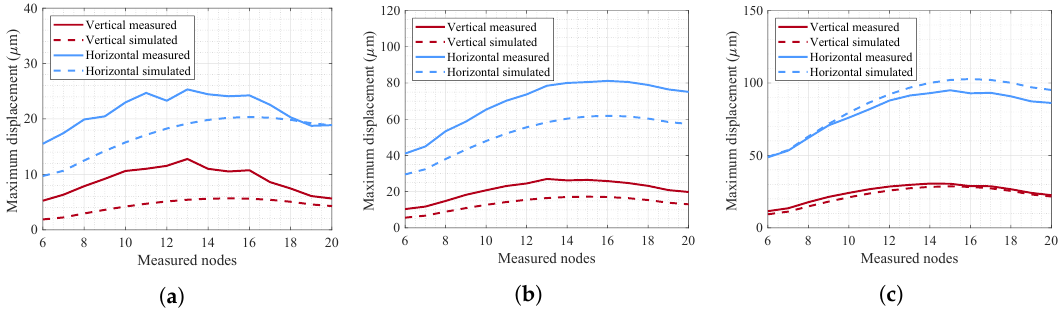
Figure 10. Comparison of deflection shape in the tube section of the guiding roll for ( a ) Case 1 ( b ) Case 2 ( c ) Case 3, using maximum displacement amplitudes from measurement and simulated model